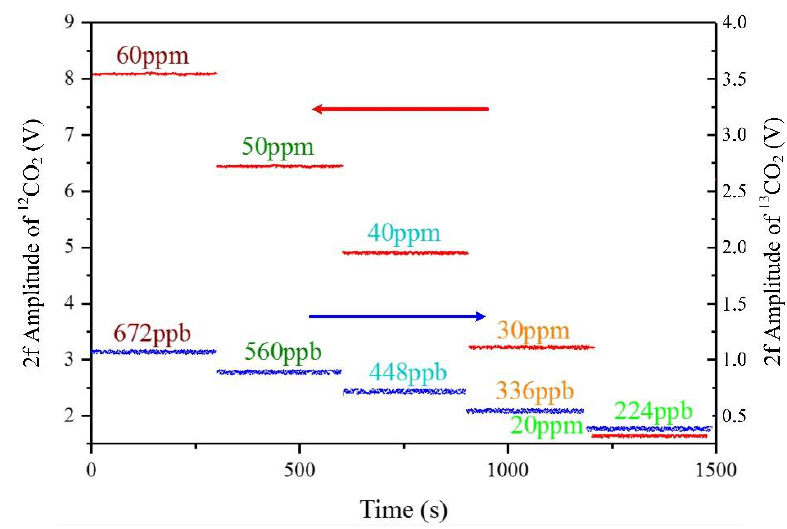
Figure 6. Peak values of the second harmonic signal of 13 CO 2 and 12 CO 2 for five different concentration levels of 20 ppm, 30 ppm, 40 ppm, 50 ppm, and 60 ppm.